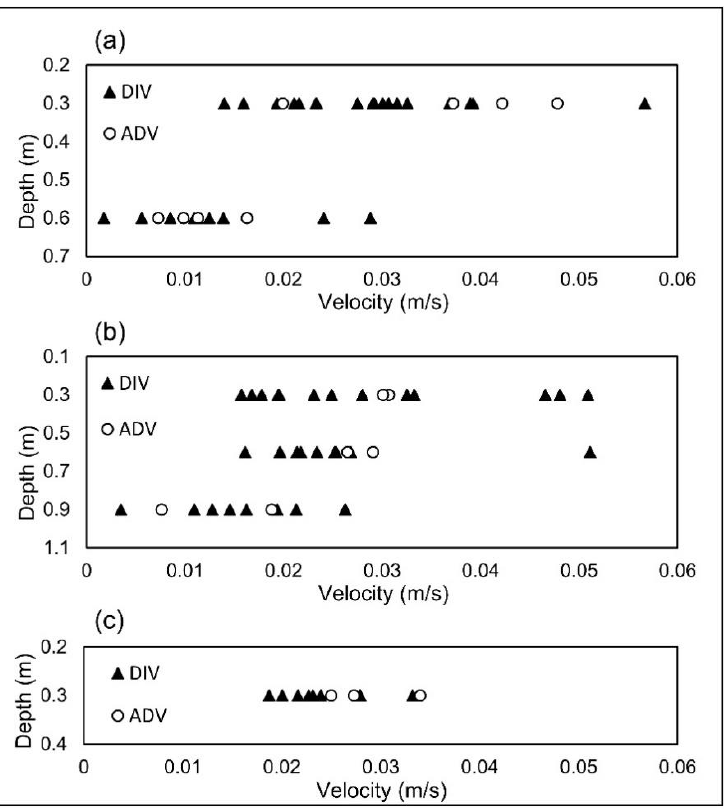
Figure 7. Validation tests results for flow velocity at ( a ) P1; ( b ) P2; and ( c ) P3.